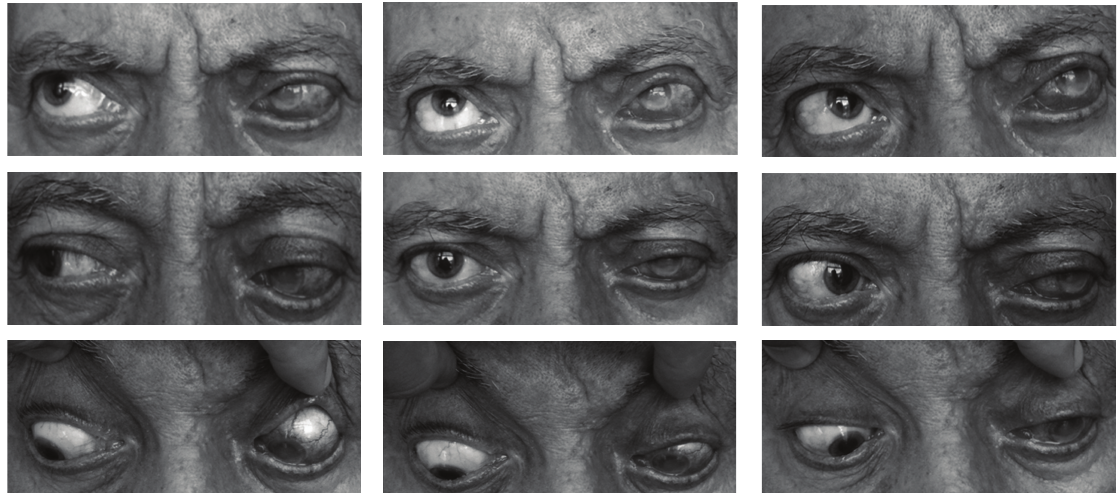
Figure 5: Partial improvement of the ocular motility and ptosis of the left eye after 5-month